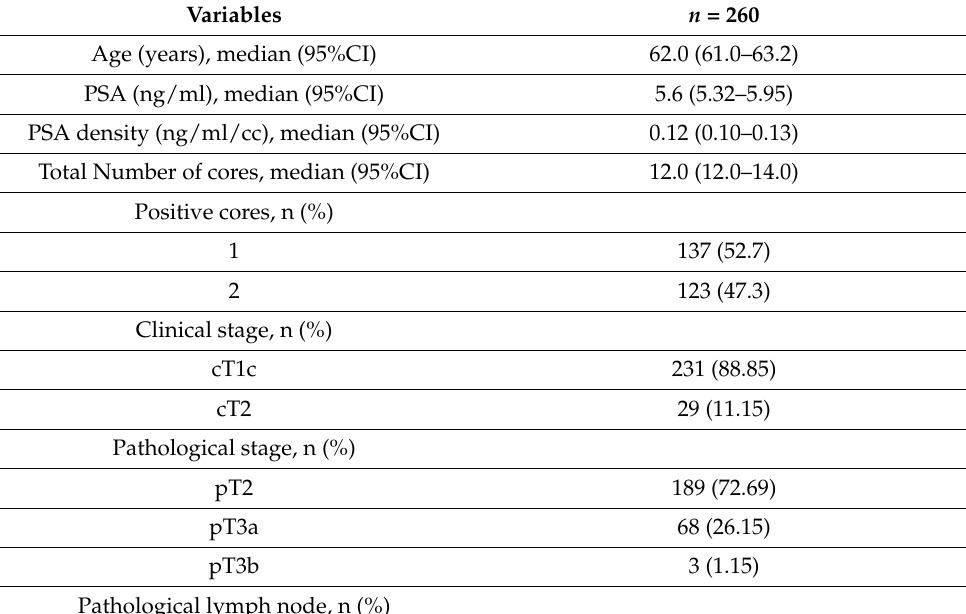
Table 1. Baseline Characteristics of the Study